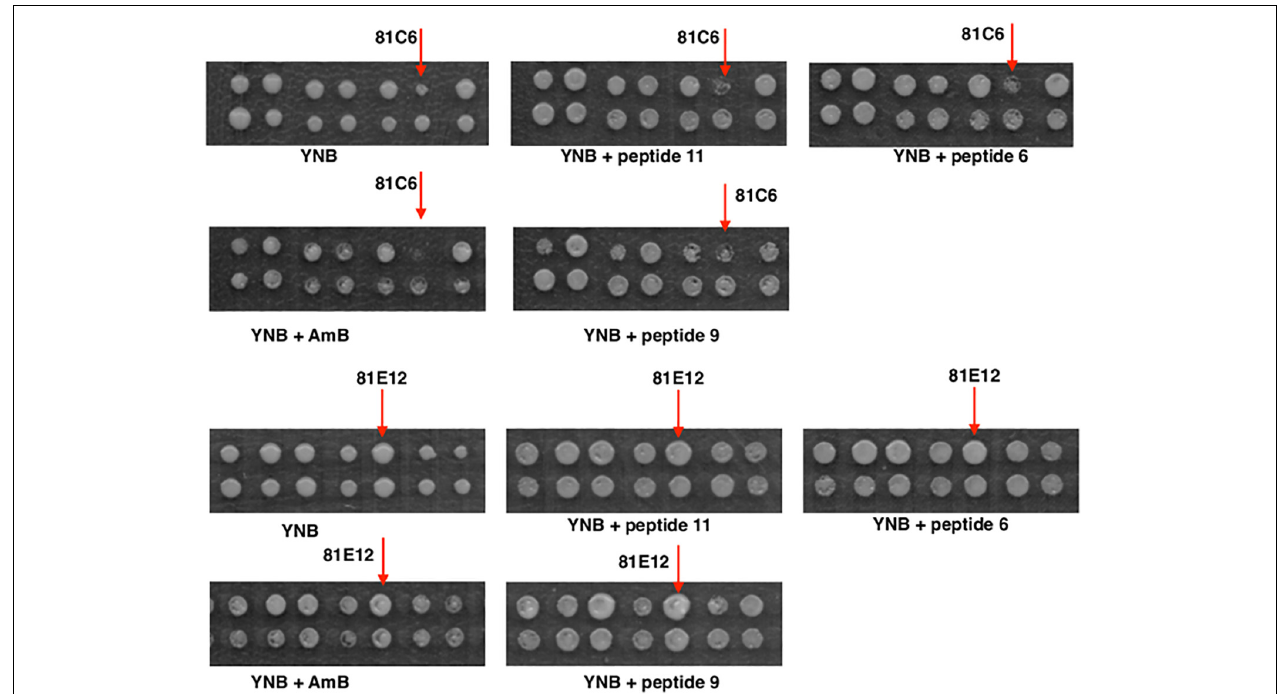
FIGURE 5 | Growth of gene library transformants of RNAi strain on antifungal peptides (#6, #9, #11) and amphotericin B (AmB). The transformants, which displayed sensitivity or resistance to the compounds tested were selected for sequencing ( arrowed ).